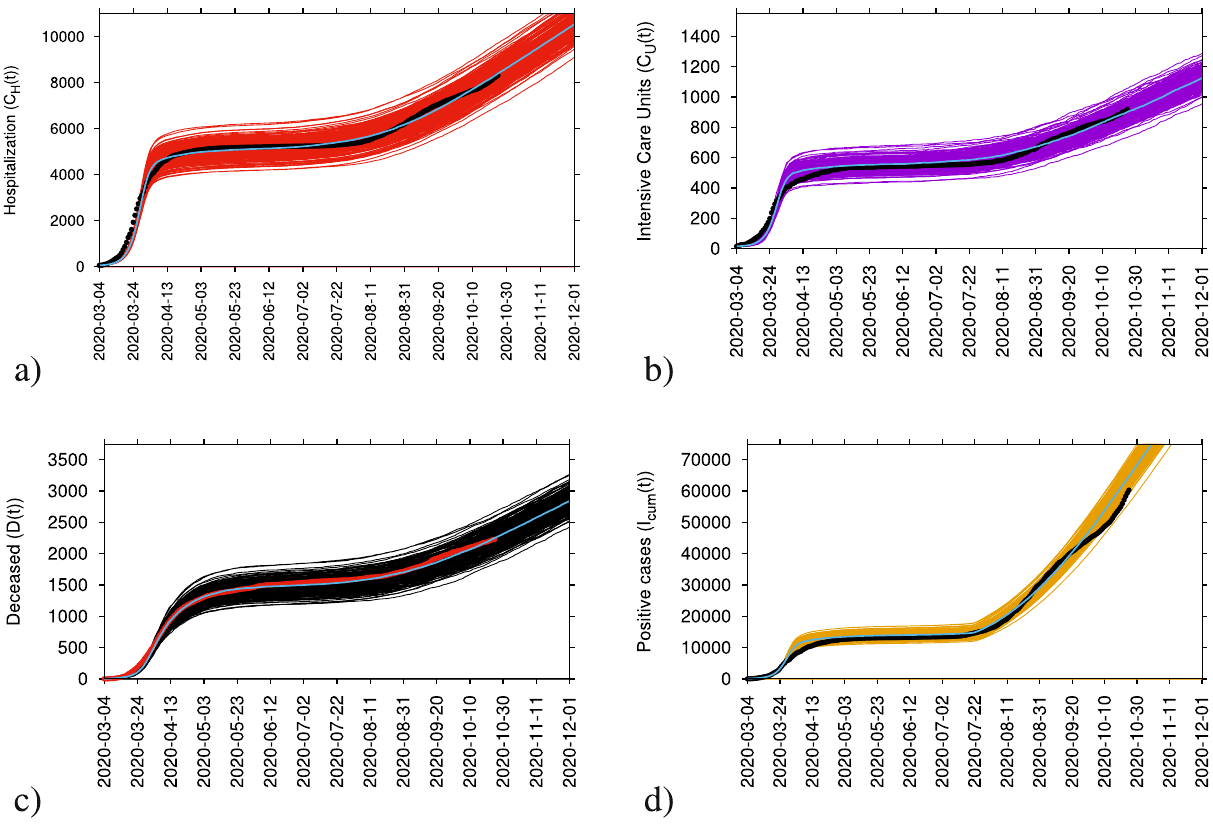
Figure 3. Ensemble of stochastic realizations of the refined SHARUCD-model with import. Starting in March 4, 2020, in ( a ) cumulative hospitalized cases C H (t), in ( b ) cumulative ICU admissions C U (t), in ( c ) cumulative deceases cases D (t) and in ( d ) cumulative positive cases I cum (t). The mean of 500 stochastic realizations is plotted in